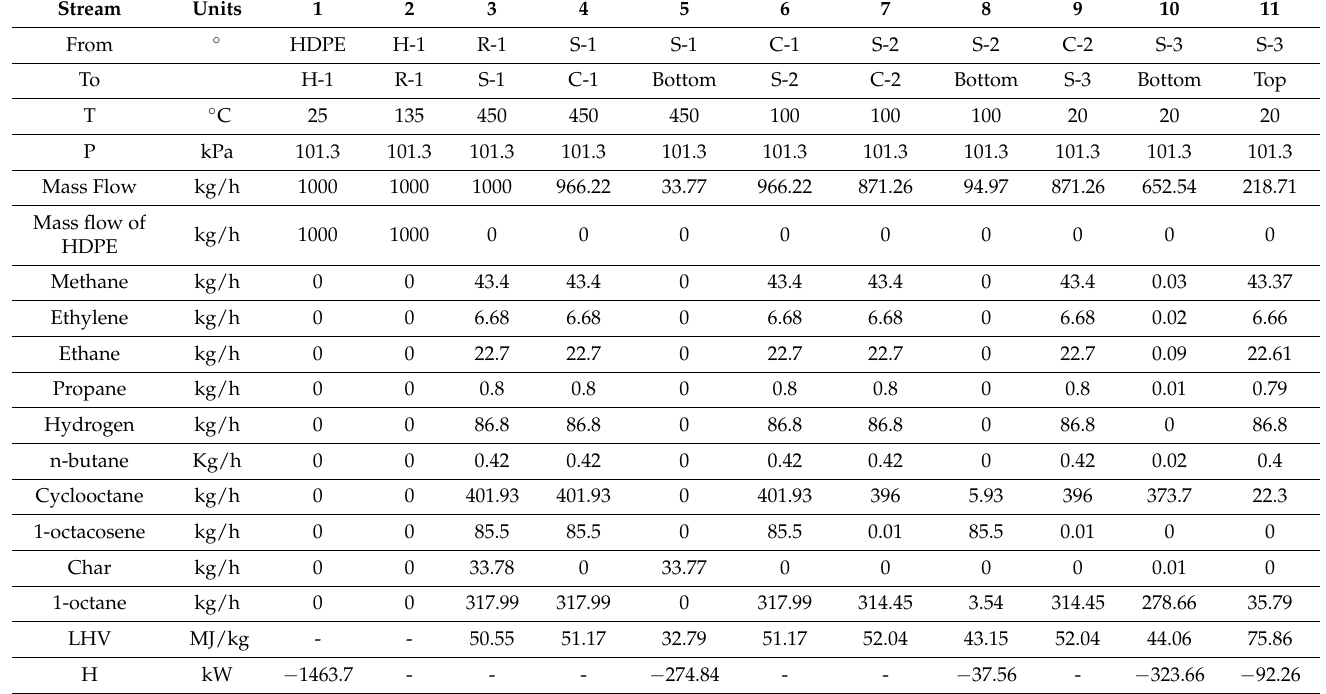
Table 1. Stream data for pyrolysis process.